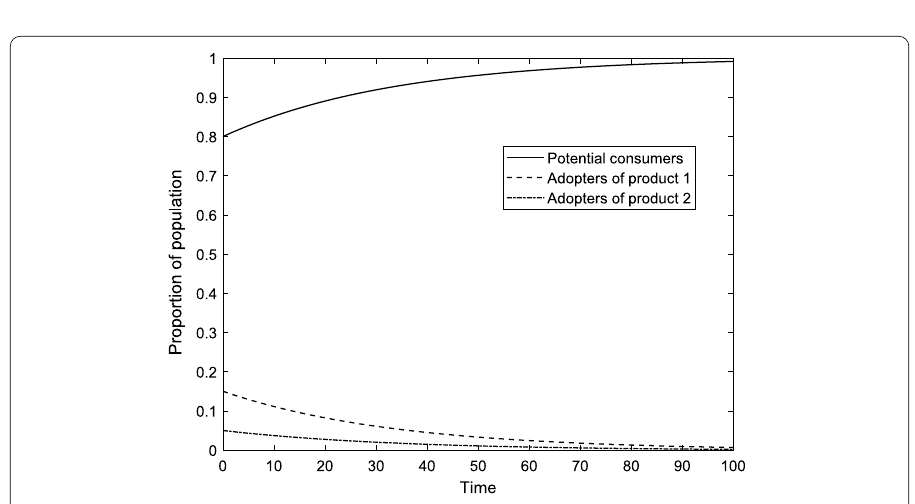
Figure 4 Two competitive products fail to diffuse without considering advertising